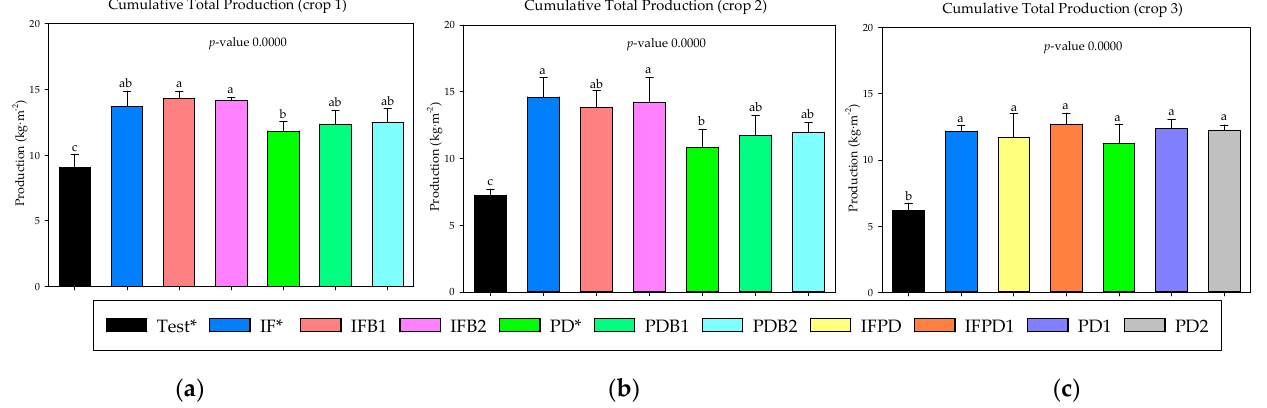
Figure 1. Cumulative tomato production in the three years of study (September–April cycles) as a function of crop nutrition: ( a ) Crop 1; ( b ): Crop 2; ( c ): Crop 3. Values (mean ± standard deviation). Different letters indicate significant differences ( p ≤ 0.05, Tukey’s HDS test). No fertilization (test); inorganic fertilization (IF); inorganic fertilization + 0.5 kg·m −2 of Brassica carinata pellets (IFB1); inorganic fertilization + 1.0 kg·m −2 of Brassica carinata pellets (IFB2); 3.5 kg·m −2 of tomato plant debris (PD); 3.5 kg·m −2 of tomato plant debris + 0.5 kg·m −2 of Brassica carinata pellets (PDB1); 3.5 kg·m −2 of